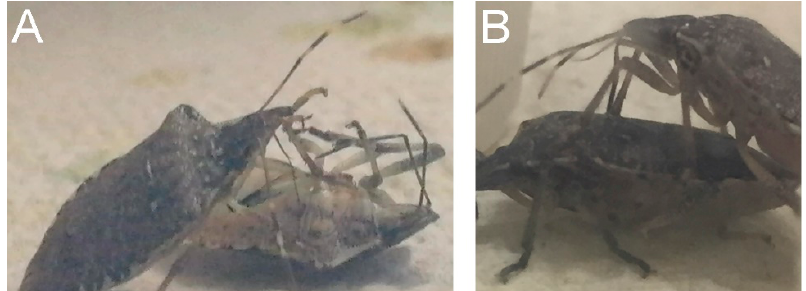
Figure 1. Prey and predators of Halyomorpha halys . ( A ) Frame of Video S1 showing cannibalism in the metathoracic ventral part of prey. ( B ) Picture showing predation in dorsal part of prey. Movement responses of prey prodded with a brush demonstrated that they were still alive (Video S3).